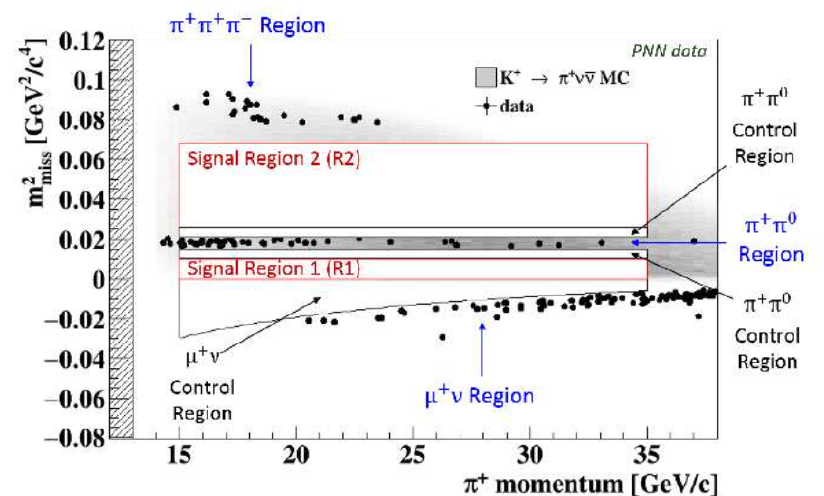
Figure 3. Squared missing mass as a function of the pion three-momentum for PNN-triggered data events (dots) passing the event selection, except for the cuts on m 2 corresponds to the distribution of K + → π + ν ¯ ν MC events, with darker (lighter) grey indicating more (less) populated regions. Red (black) lines define the signal (control) regions and are masked. Three background regions are also visible.